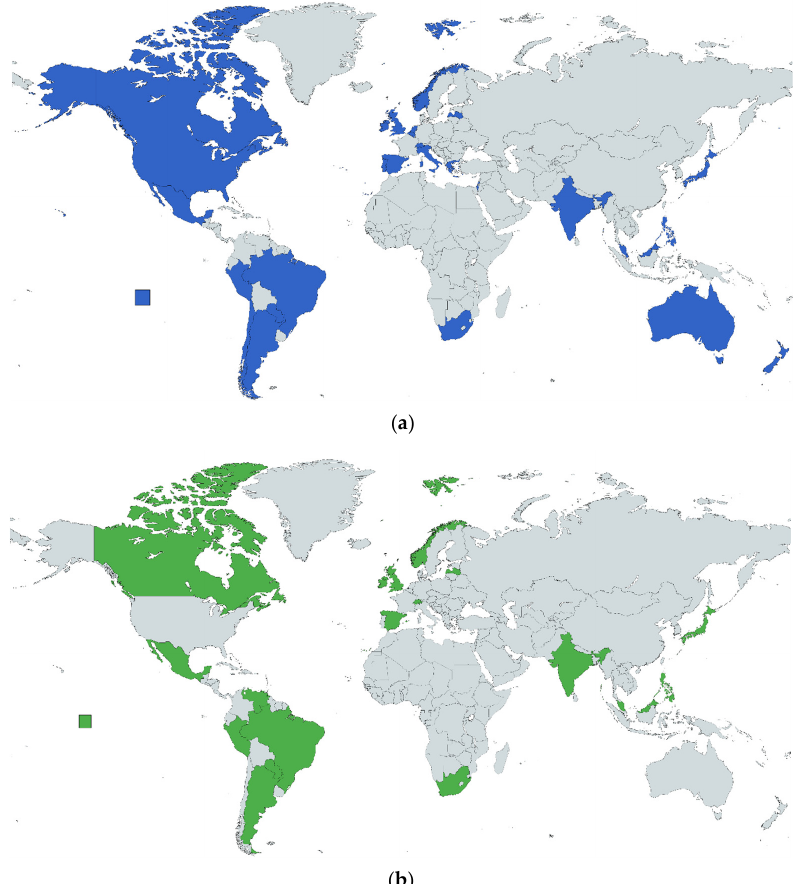
Figure 6. ( a ) Global reach of the 2022 Adult Goal Planning survey. ( b ) Global reach of the 2022 CYP Goal Planning survey.